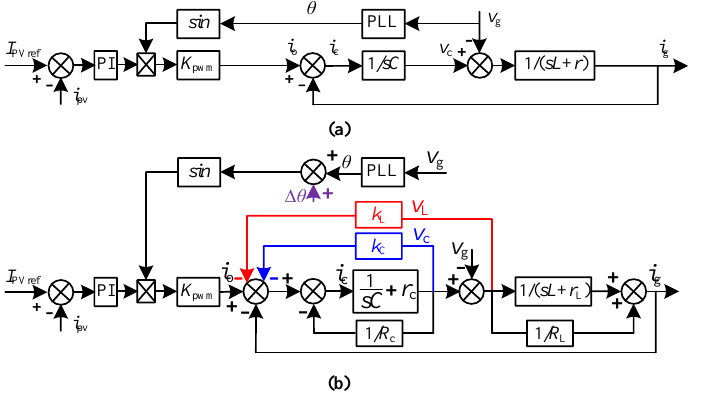
R C = Figure 8. Bode plot of CL filter with damping. The control strategy of the 3CH4 grid-connected inverter should comprehensively consider modulation strategy, input to output gain, voltage and current stress, and hybrid damping correction to improve steady-state and transient performance. 3. Control Strategy and Parameter Design The PV 3CH4 grid-connected inverter comprises three independent CH4s, and the phase currents are not coupled. Therefore, it can be controlled as a combined 3CH4 grid- connected inverter. Common control strategies for grid-connected inverters include DC current PI control combined with grid voltage feed-forward and grid current PR control. PI control parameters are easy to set, with high reliability and robustness; however, there is a large phase difference when tracking sinusoidal signals, which belongs to differential regulation. The PR controller can stably track the sinusoidal signal at a specific frequency without the need for a feed-forward voltage and can eliminate the steady-state errors in